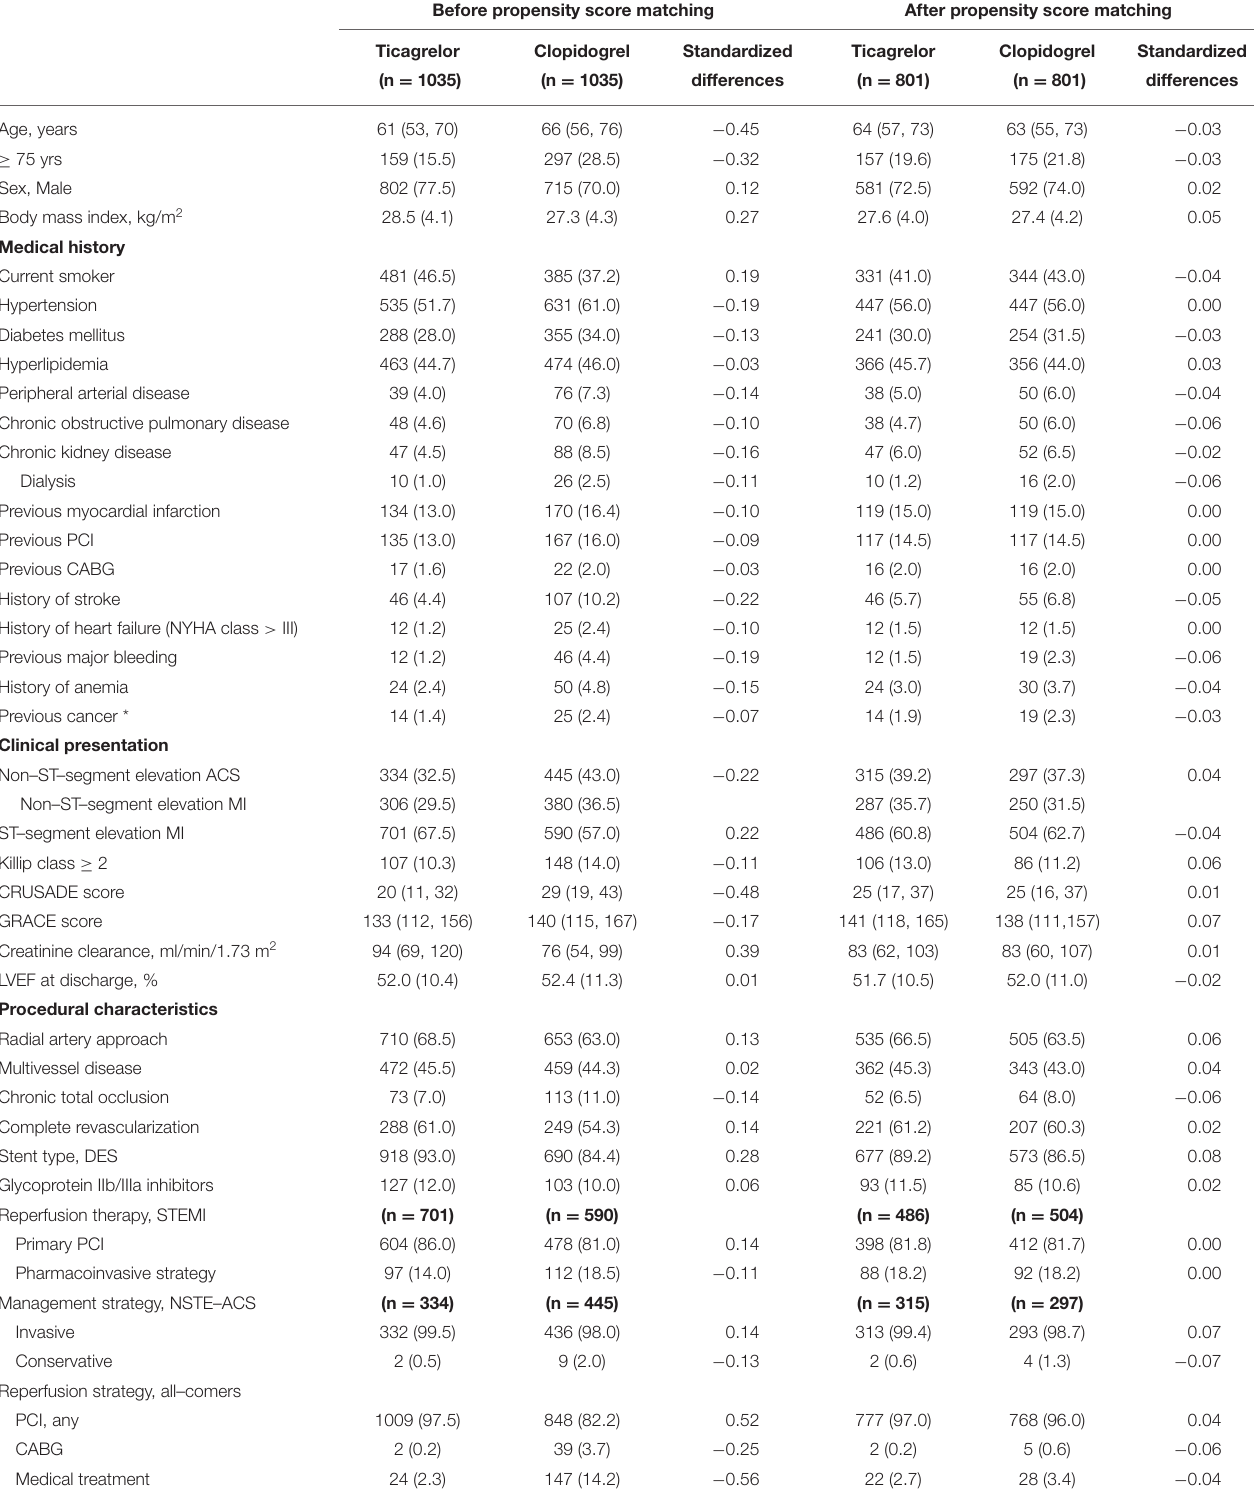
TABLE 5 | Standardized covariate mean differences stratified by treatment before and after matching. Before propensity score matching After propensity score matching Ticagrelor Clopidogrel Standardized